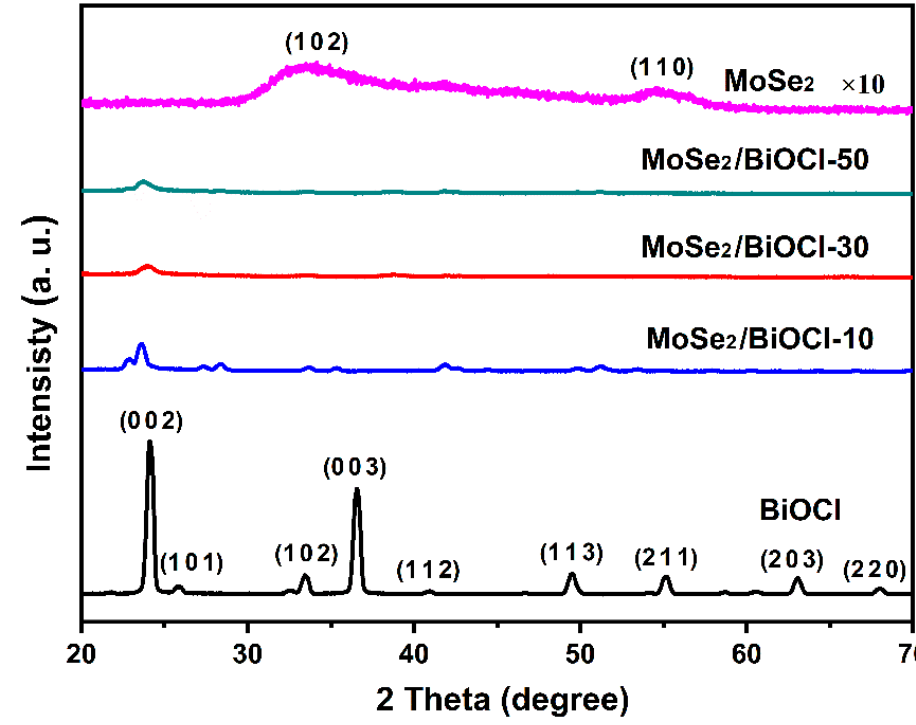
Figure 2. XRD patterns of MoSe 2 , BiOCl, BiOCl/MoSe 2 -10, BiOCl/MoSe 2 -30, and BiOCl/MoSe 2 -50.